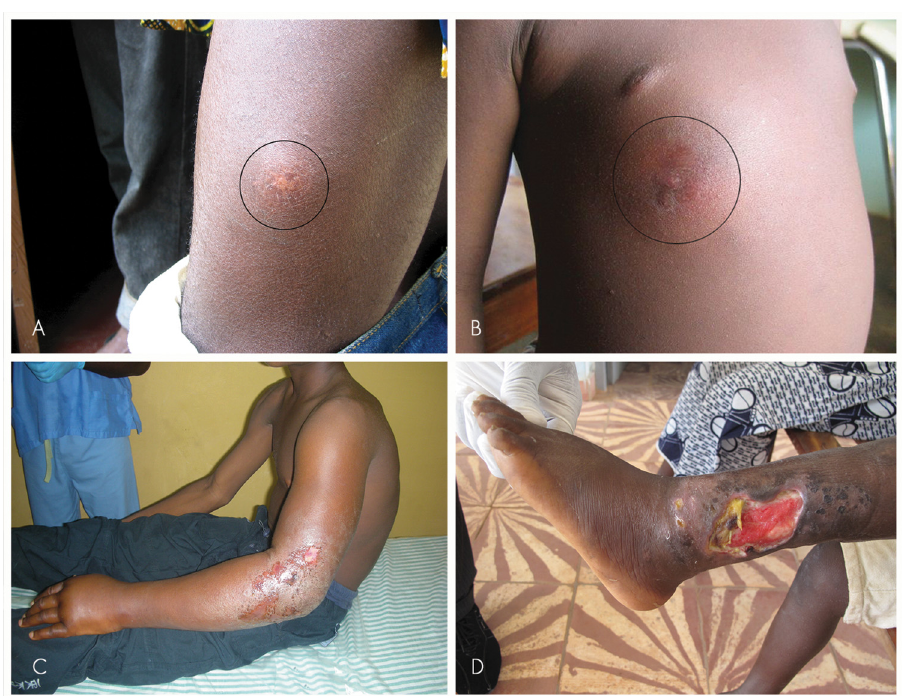
Fig 1. Clinical forms of Buruli ulcer showing a nodule (A), plaque (B), edema (C) and ulcer (D) (courtesy of World Health